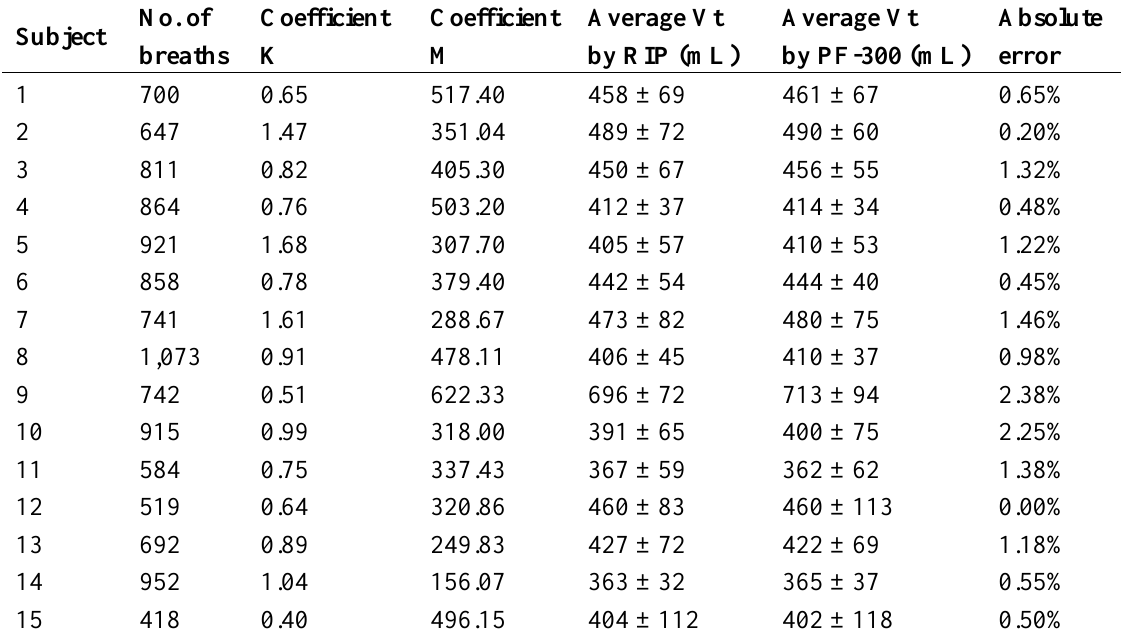
Table 1. Average Vt by RIP and PF-300 of 15 Volunteers and corresponding calibration coefficient K and M by QDC